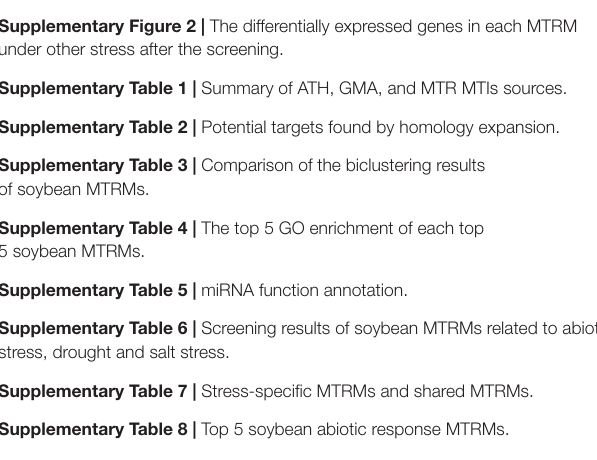
Supplementary Table 7 | Stress-specific MTRMs and shared